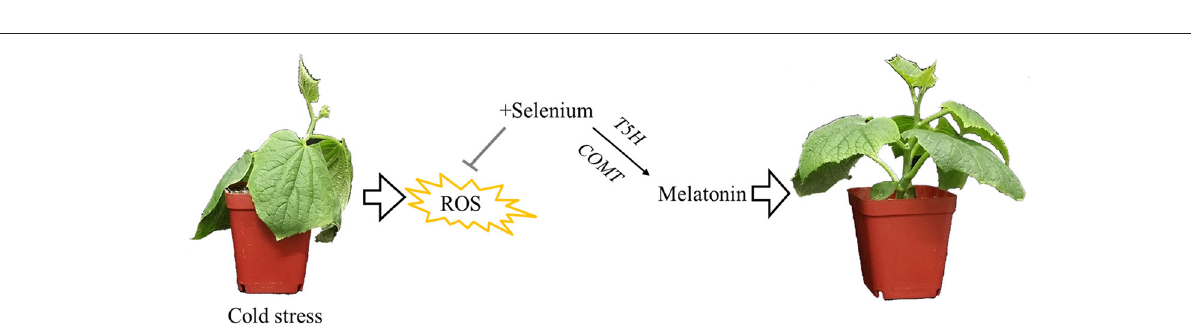
FIGURE 6 | Schematic illustration for melatonin participated in enhancing cold tolerance by exogenous application of selenium. Cold stress inhibited plant growth and increased the production of reactive oxygen species; however, selenium reduced cold stress damage to the plant. Meanwhile, melatonin as the downstream signaling participated in selenium-enhanced cold tolerance of cucumber seedlings. Melatonin biosynthesis genes T5H and COMT play vital roles in exogenous selenium application enhancing the melatonin content, promoting plant cold